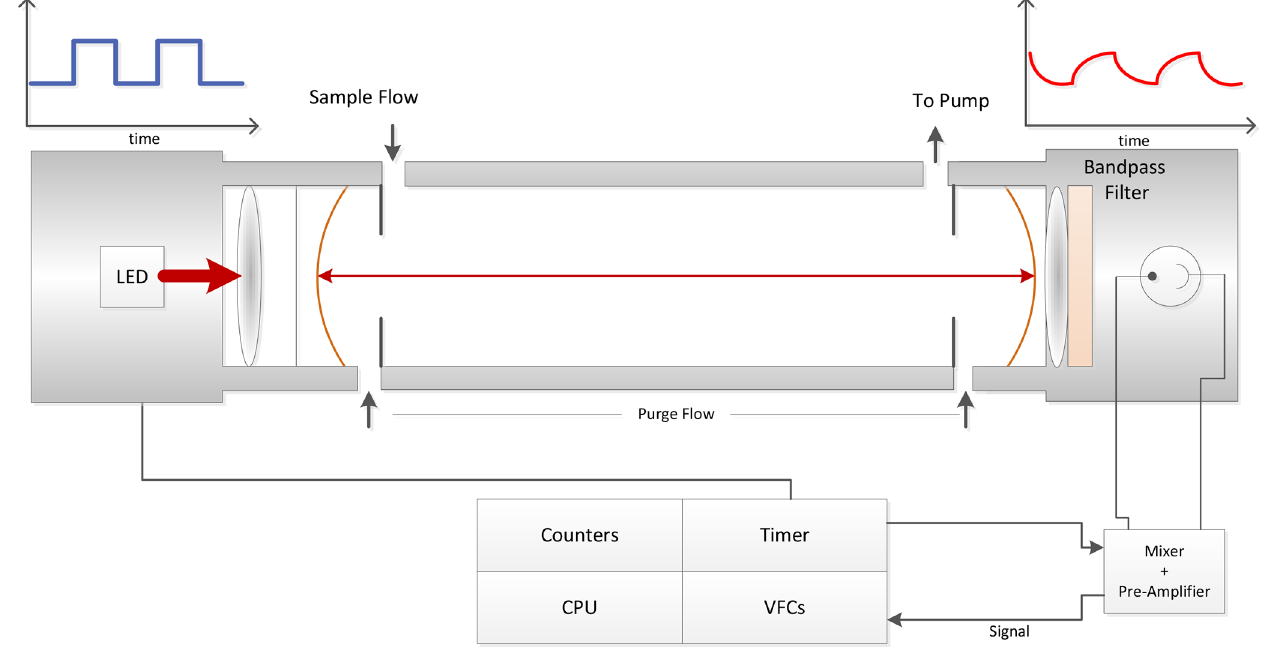
Figure 2. Overview of the main components and operation principle of the CAPS PM ex instrument (Massoli et al., 2010).